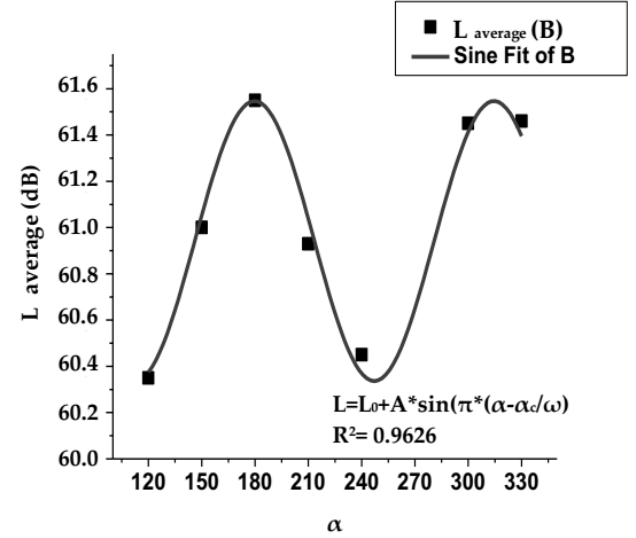
Figure 8. Average L eq at OW-L[9].